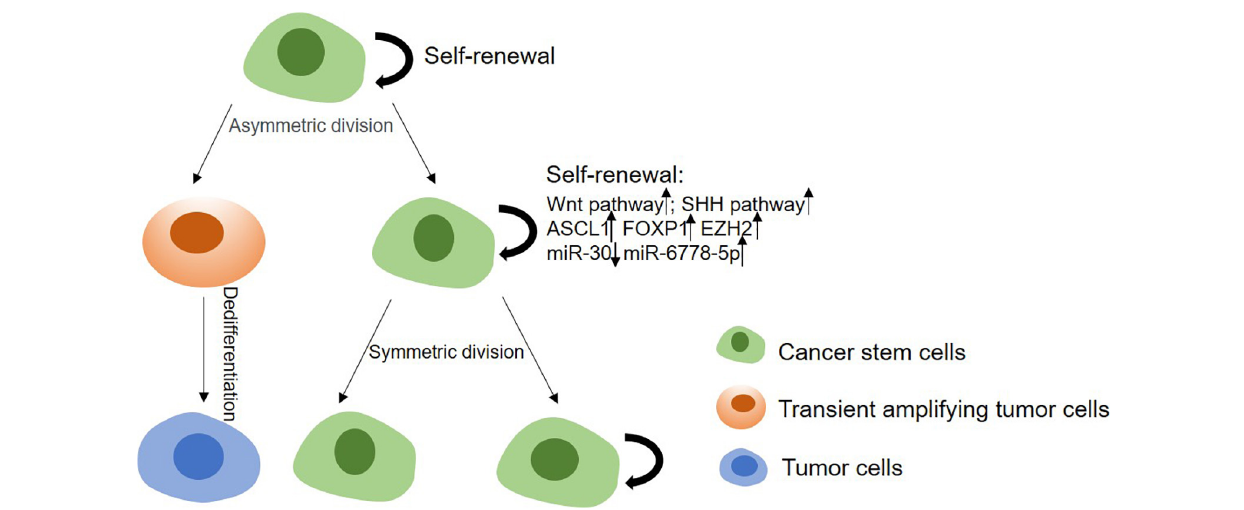
FIGURE 2 | The mechanism of stemness maintenance of CSCs. In CSCs model, CSCs can progress into solid tumors due to their self-renewal and proliferation capabilities. CSCs can give rise to transient amplifying cells, and then develop into committed pre-malignant progenitors, differentiated malignant cells. On the other hand, CSCs can renew and proliferate themselves through upregulating Wnt, Shh, Notch pathways, or enhancing DNA damage repair ability,